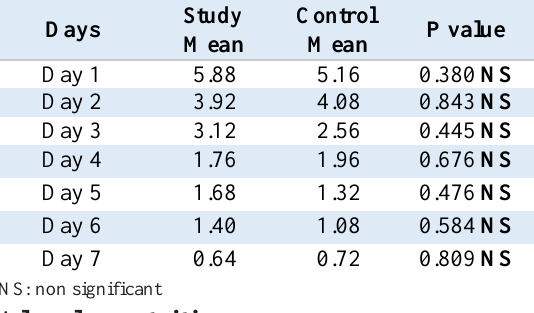
Table 4: Pain score between both groups using numeric rating scale.